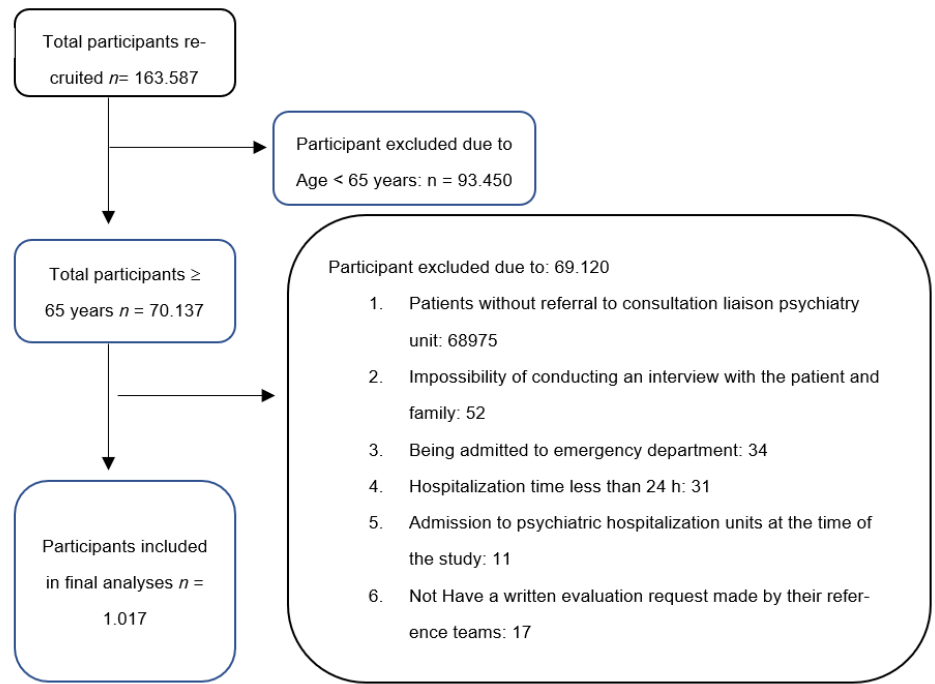
Figure 1. Study flow Diagram.